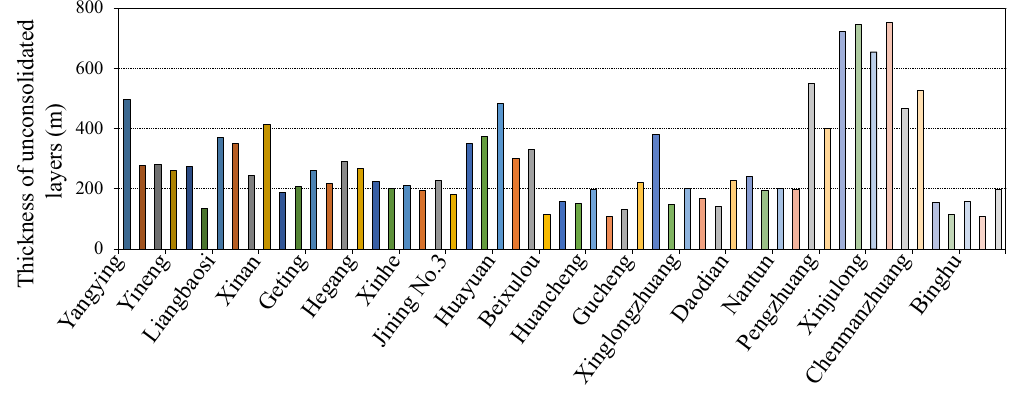
Figure 1. Thickness of unconsolidated layers in coal mines in western Shandong Province coal